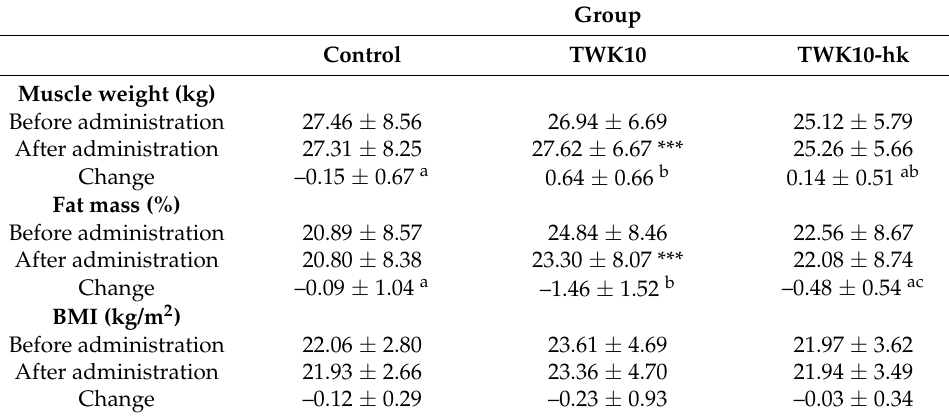
Table 2. Effects of TWK10 on muscle weight and fat